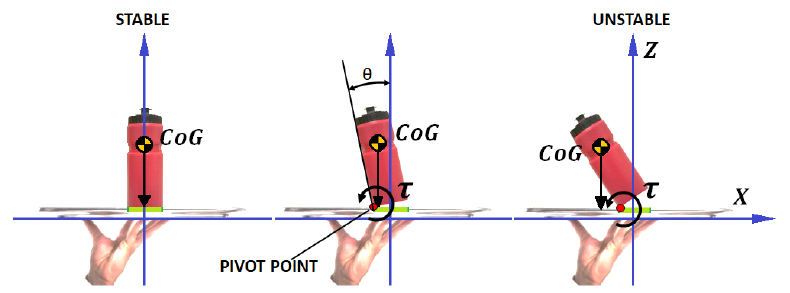
Figure 8. Different degrees of stability applied to the LIPM